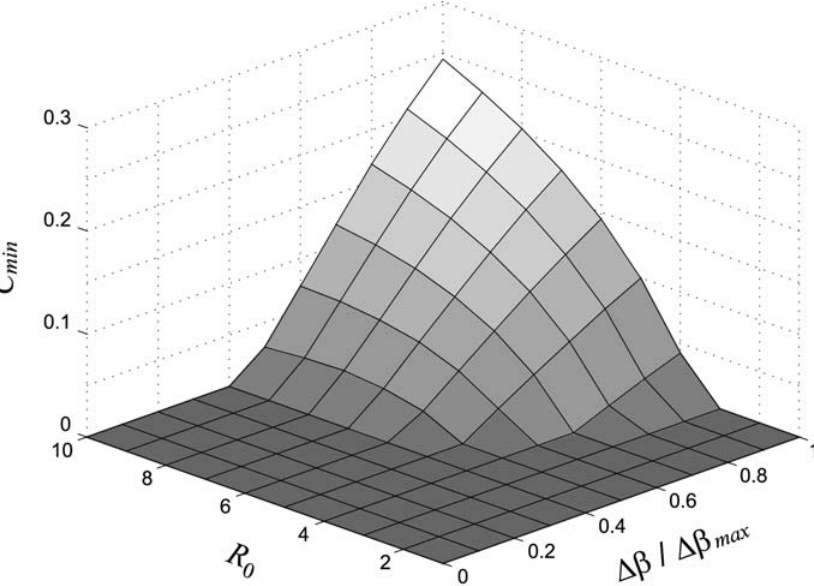
Figure 2. Value of the minimum culling rate C min required for disease prevalence to drop the value attained in absence of culling as a function of the basic reproduction number (R 0 ) and the age-dependent heterogeneity in transmission ( Db = b a 2 b j ) renormalized by the maximum heterogeneities in transmission ( Db max ) allowed at each level of R 0 (see Protocol S2).